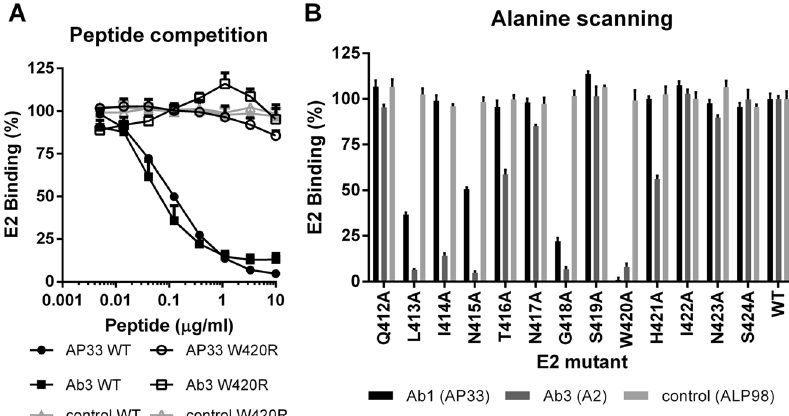
Fig. 5 Alanine scanning and peptide competition shows that Ab1 ′ antibodies bind to the same epitope as AP33. A representative Ab3 serum (1:300 dilution) was ( a ) pre-incubated with E2 412 – 423 WT peptide (solid) or with a W420R mutant sequence (open symbols), and then tested by ELISA for binding to E2 661 , ( b ) tested for binding to a panel of E2 mutants, in which each residue in turn from 412 to 424 was replaced by alanine, MAbs AP33, and ALP98 served as positive and negative controls, respectively. Values shown are the mean and SD of three ELISAs. Very similar results were obtained with other Ab3 sera.